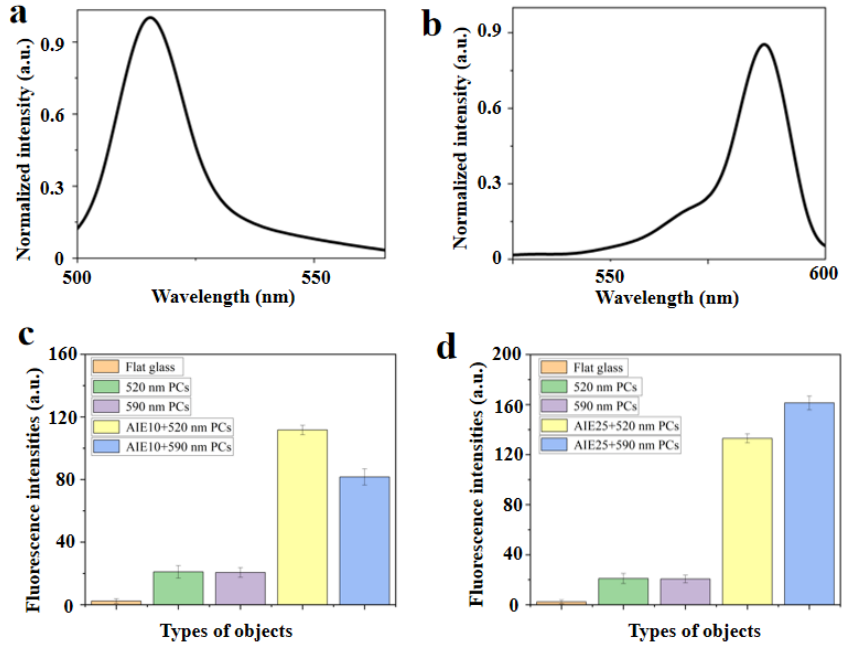
Figure 3. Emission spectra of ( a ) AIE10 and ( b ) AIE25 in ethanol. Fluorescence intensities of flat glass, PCs with different reflection peaks, and PCs incorporating ( c ) AIE10 and ( d ) AIE25.